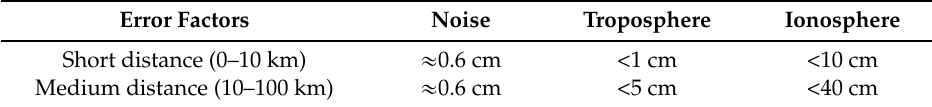
Table 4. DD phase error budgets for short and medium distance [26].